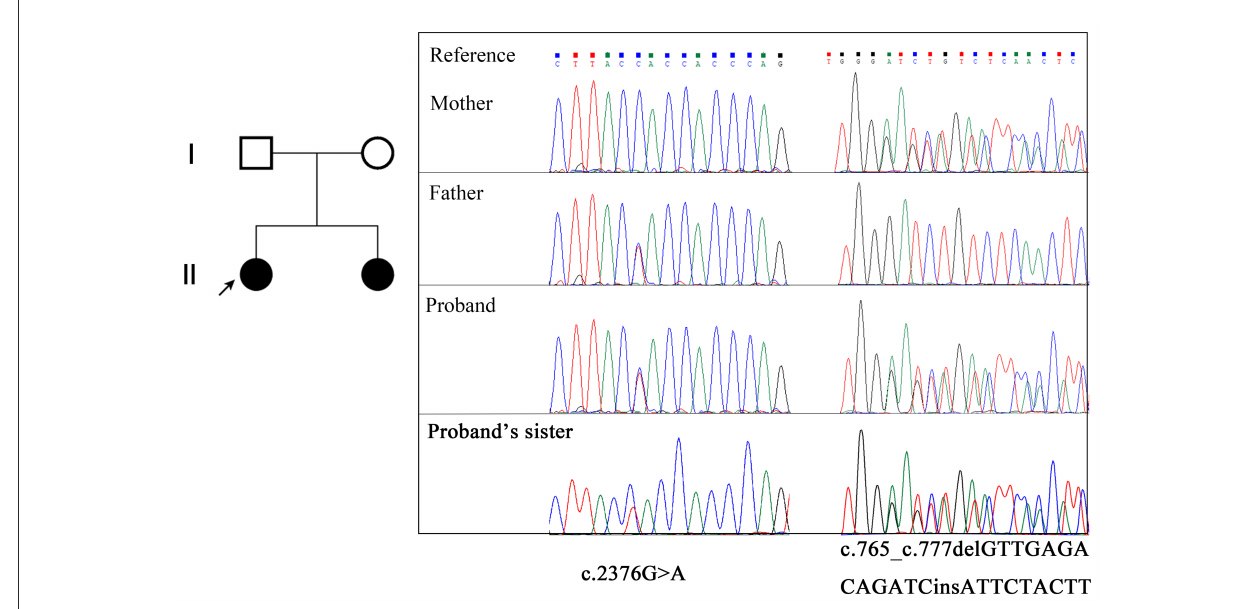
FIGURE1 Pedigree of the family and EMC1 variants confirmed by Sanger sequencing. The proband is indicated with an arrow.